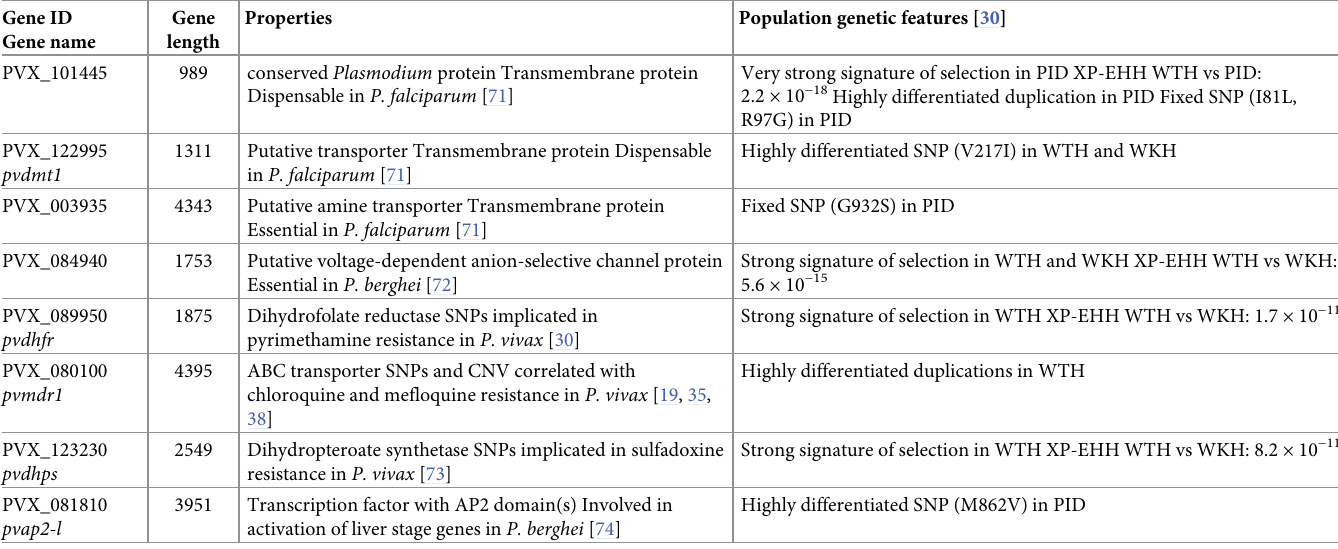
Table 2. Plasmodium vivax genes expressed in Plasmodium knowlesi